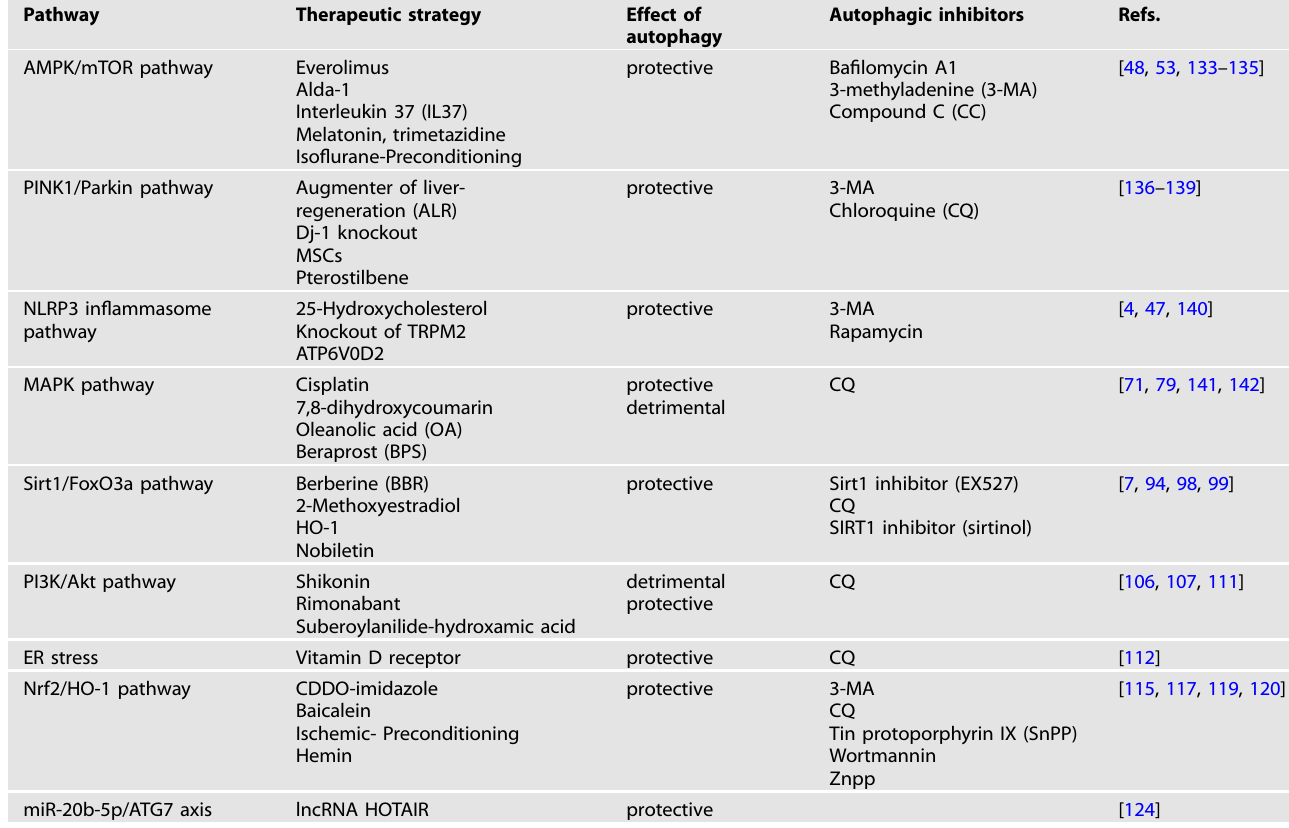
Table. 1. Summary of the studies of autophagy on HIRI in different experimental